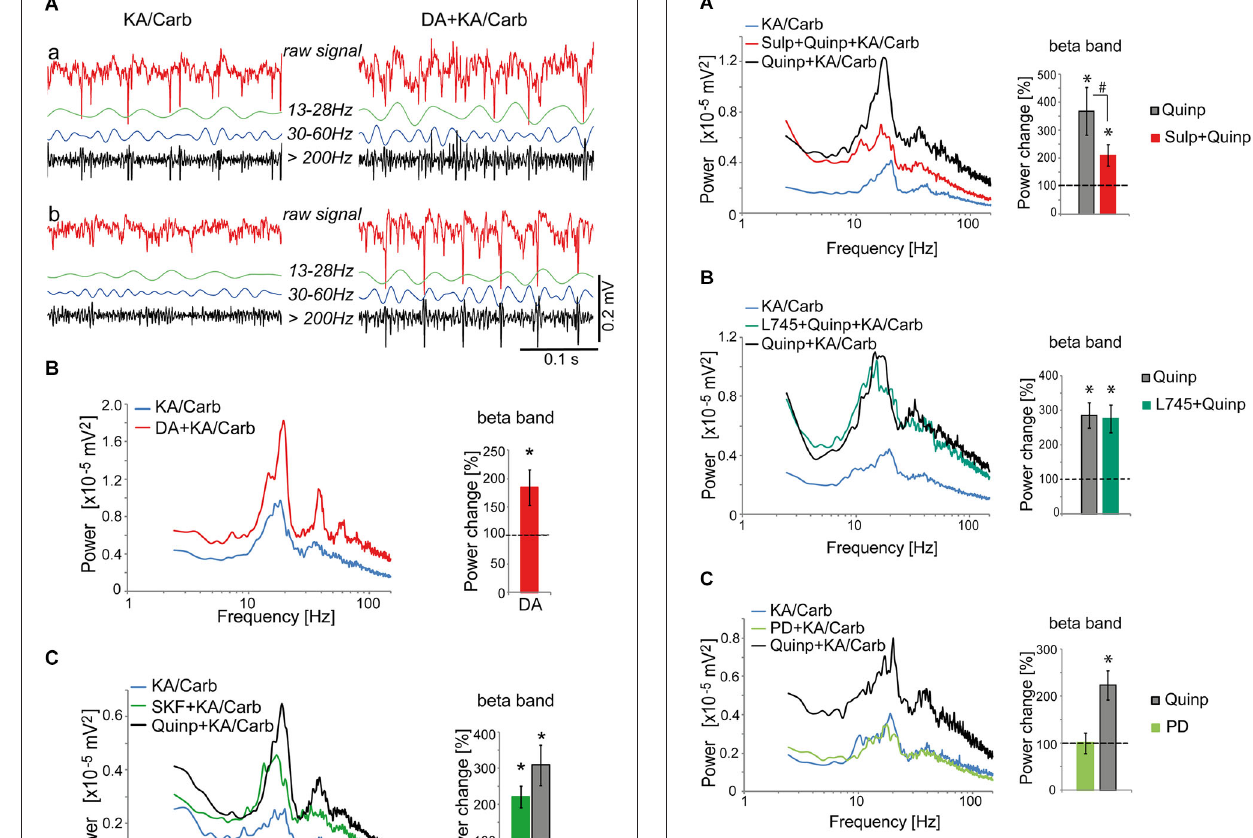
FIGURE 2 | Activation of D2R, but not D4R, enhances the power of high-frequency oscillations in the ACC . (A) Activation of D2R enhances the power of the oscillations induced by kainate + carbachol (KA/Carb) (one-tailed, P = 0.001, n = 12). The D2R antagonist (sulpiride, Sulp, 10 µ M) significantly reduces the power increase induced by quinpirole (Quinp, 1 µ M) (one-tailed, P = 0.001). However, Sulp does not fully prevent the Quinp-induced increase in power (Quinp + Sulp vs. no D2R modulator condition: one-tailed, P = 0.007). Left : power spectra of recordings (mean of pooled data). Right : Change in the power of the oscillations induced by Quinp and by Quinp + Sulp, respectively (100% corresponds to the power of oscillations elicited by KA/Carb in absence of dopaminergic modulators). * P < 0.05, significantly different from the KA/Carb condition after Bonferroni correction; # P < 0.05, significantly different between the two conditions after Bonferroni correction. (B) The D4R antagonist (L745.870, L745, 10 µ M) does not decrease the Quinp-induced enhancement of the power of oscillations elicited by KA/Carb (Quinp vs. Quinp + L754: P > 0.05, n = 15). Quinp as well as Quinp + L745 increase significantly the power of oscillations elicited by KA/Carb (for both, one-tailed, P < 0.0005). Left : power spectra of recordings (mean of pooled data). Right : Change in the power of the oscillations induced by Quinp and by Quinp + L745, respectively (100% corresponds to the power of oscillations elicited by KA/Carb in absence of dopaminergic modulators). * P < 0.05, significantly different from the KA/Carb condition after Bonferroni correction. (C) Activation of D4R does not enhance the power of the oscillations that are induced by KA/Carb. While Quinp significantly increases the power (one-tailed, P = 0.009, n = 7), the D4R agonist (PD168.077, PD, 0.4 µ M) does not (one-tailed, P > 0.05). Left : power spectra of recordings (mean of pooled data). Right : Change in the power of the oscillations induced by Quinp and PD, respectively (100% corresponds to the power of oscillations elicited by KA/Carb in absence of DA agonists). * P < 0.05, significantly different from the KA/Carb condition after Bonferroni correction. Bars,